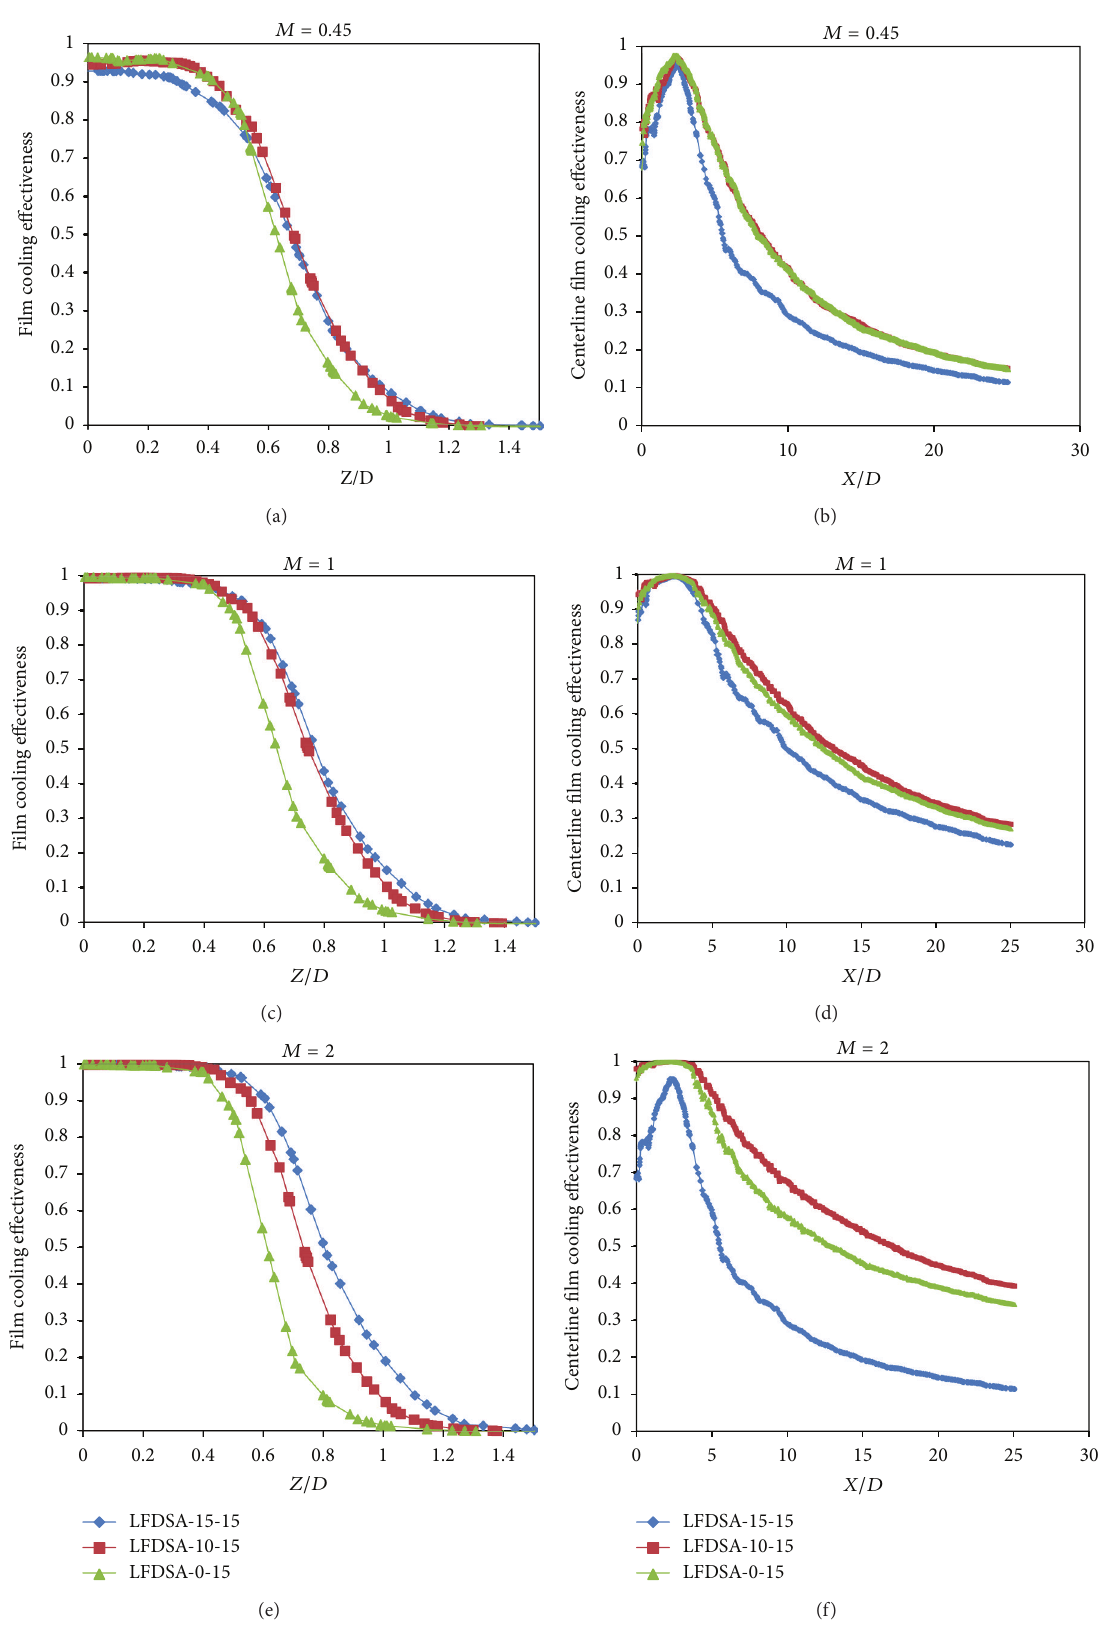
Figure 23: Effect of hole lateral angle on streamwise and spanwise (𝑋/𝐷 = 2) film cooling effectiveness for cooling hole forward angle of 15deg and streamwise angle of 30